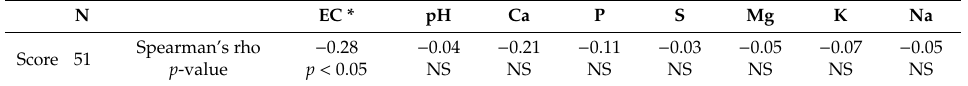
Table 2. Spearman’s rank correlation between the taste score and the properties of airag . N EC